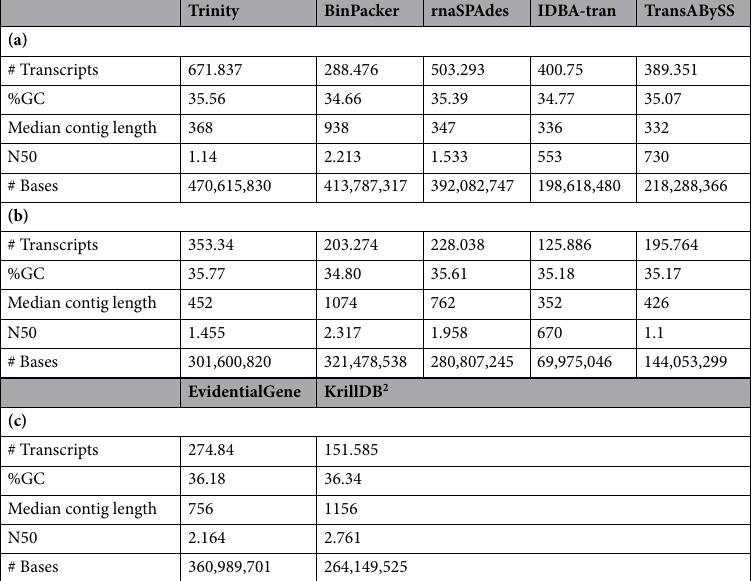
Table 1. Quality measures computed at each assembly step, from the independent de novo assembly algorithms (a), after the first filtering process (b) and finally comparing the quality of the EvidentialGene meta- assembly and the final krill transcriptome after the redundancy filter (c).